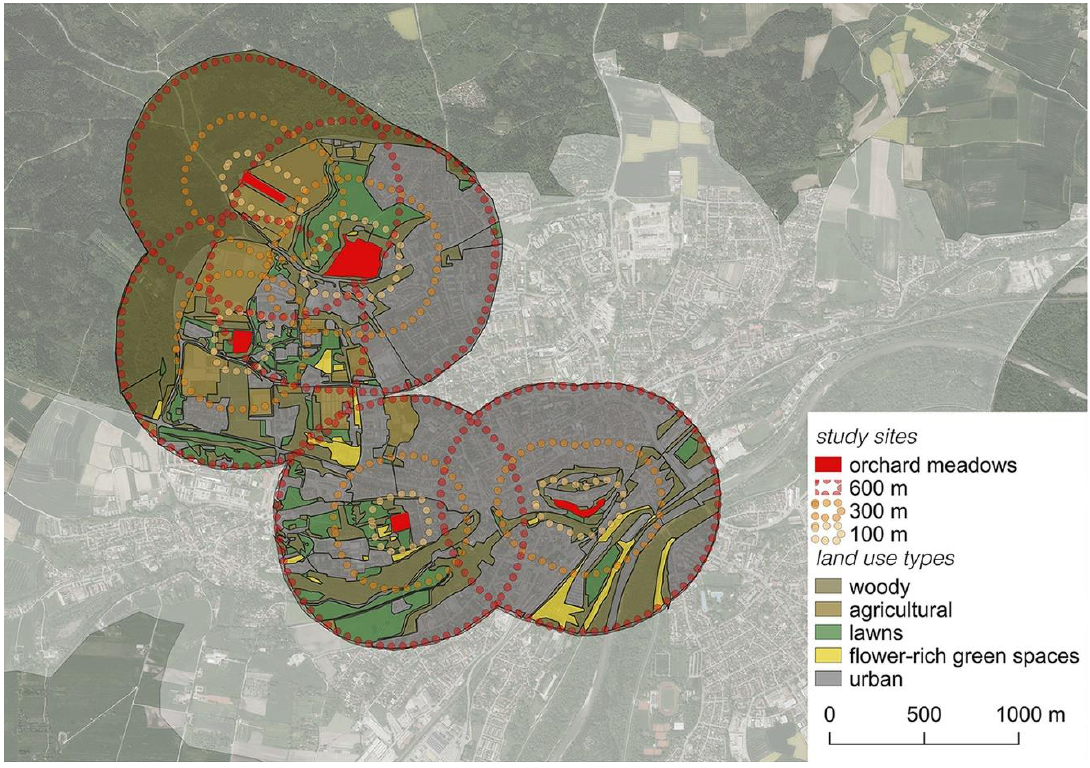
Figure 2. Land use surrounding the studied orchards (basemap: Landesamt für Digitalisierung, Breitband und Vermessung (CC